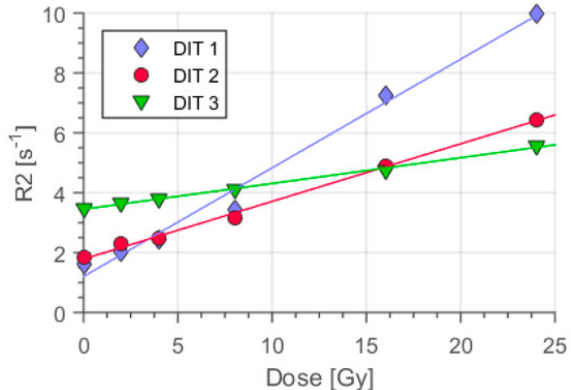
Figure 8. Dosimetric response of methacrylic acid gels produced with different concentrations of dithiothreitol oxygen scavenger (DIT1: 2 mmol/kg, DIT2: 10 mmol/kg, and DIT3: 50 mmol/kg). Reproduced from [93].